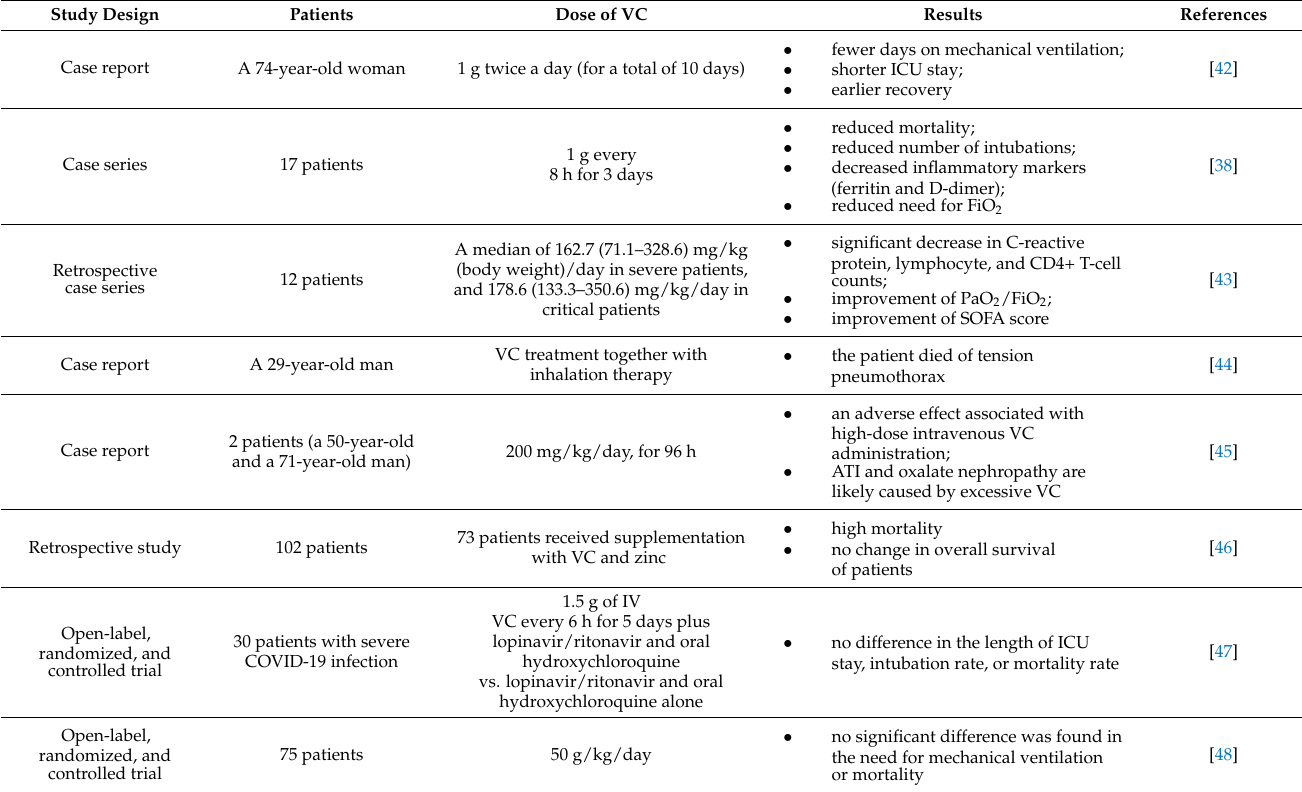
Table 1. Effect of VC treatment/supplementation among COVID-19